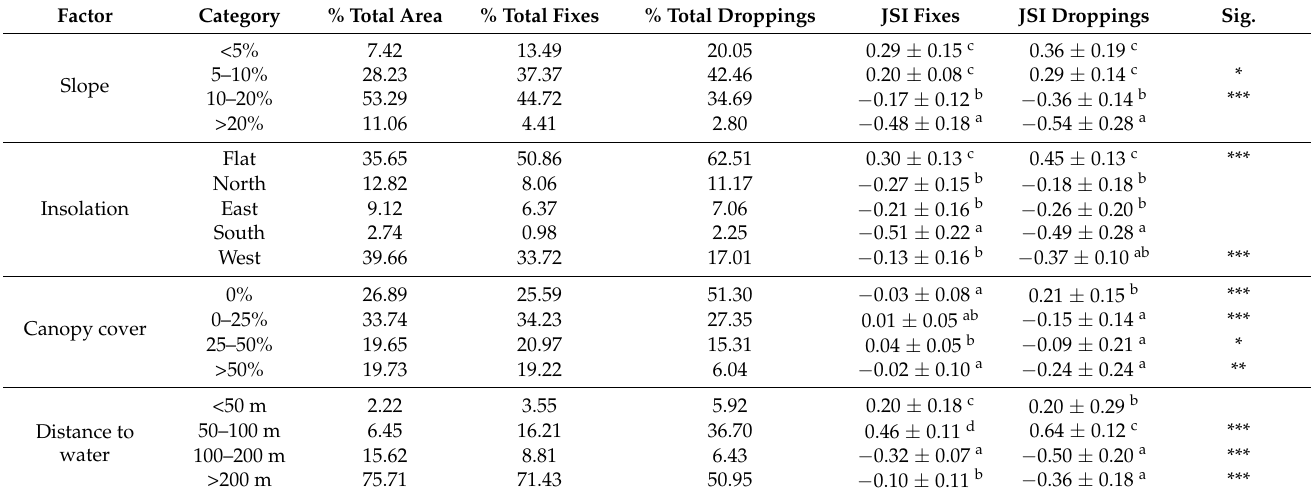
Table 1. Animal and dung distribution within the experimental paddock according to several